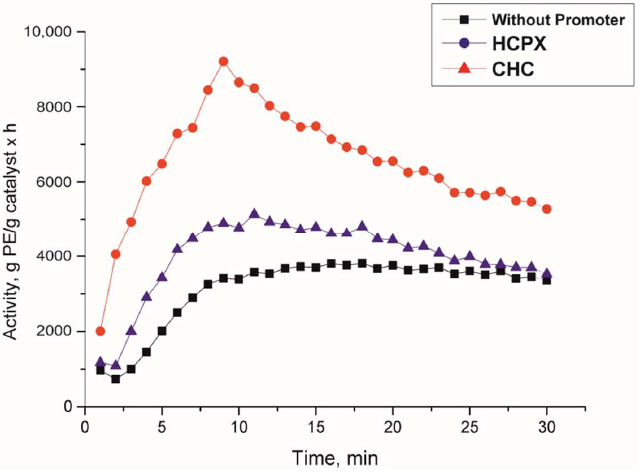
Figure 3. Activity of the catalytic system upon ethylene/1-hexene copolymerization as a function of process duration. [1-hexene] = 0.32 mol/L. 3—TMC; 9—TMC–HCPX; 6—TMC–CHC. The conditions are listed in Table 1.